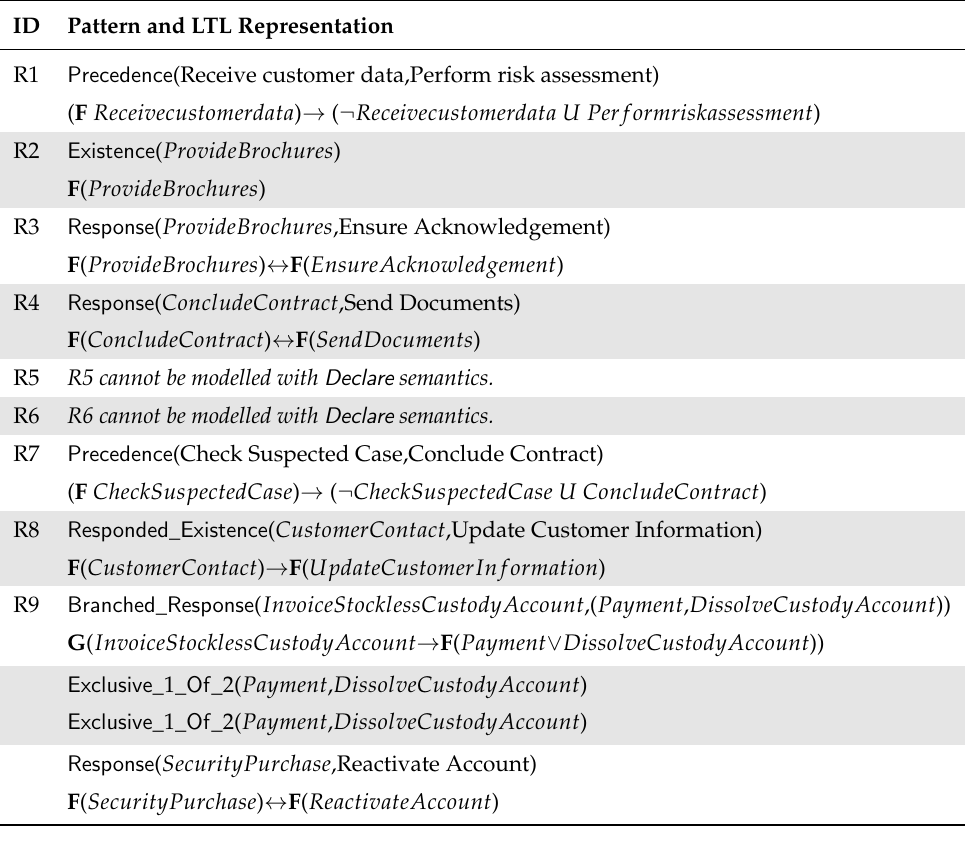
Table 9. Mapping of formalised requirements using Declare constraints to LTL